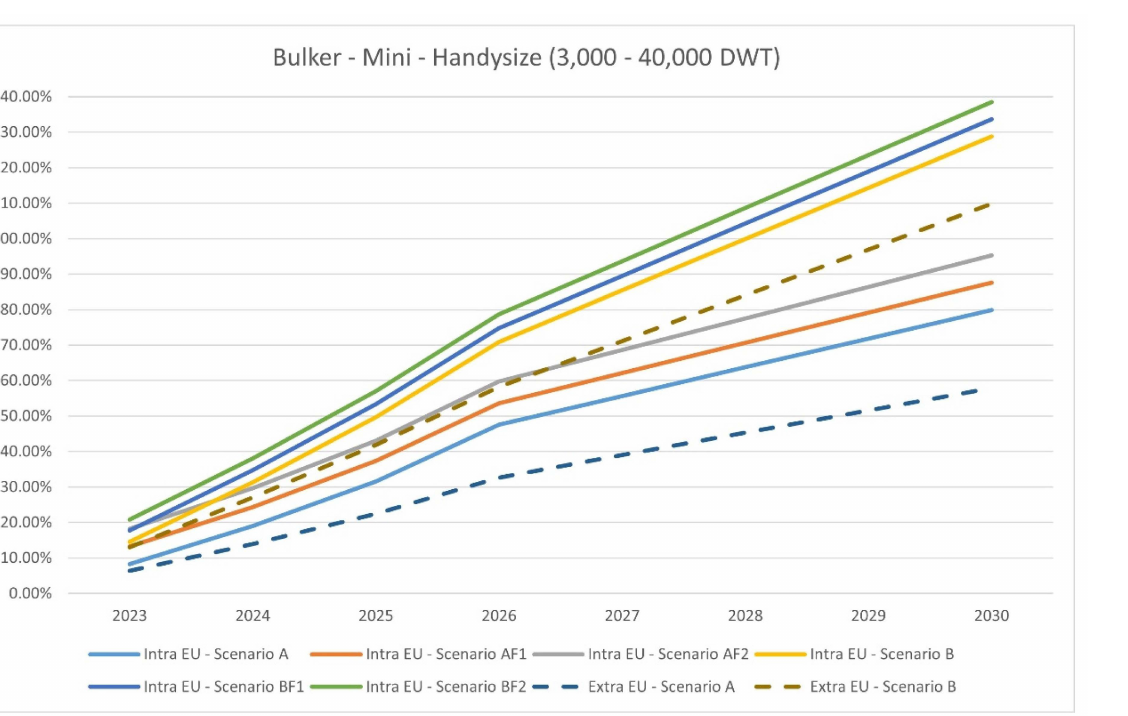
Figure 5. Effect of different scenarios on the OPEX of mini-handysize bulk carriers (3000–40,000